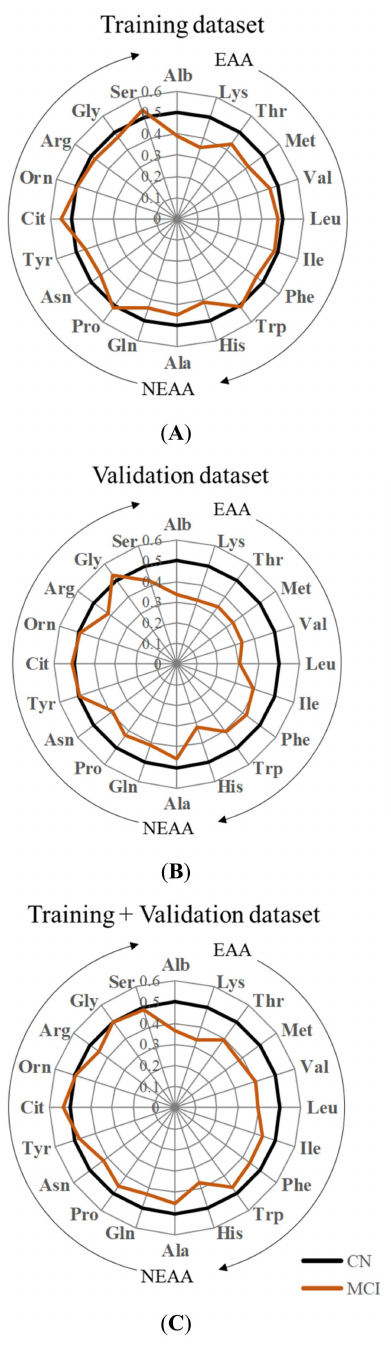
Figure 2. Albumin and PFAA profile of MCI and CN groups. ( A ) Training dataset (120 MCI and 120 CN); ( B ) validation dataset (99 MCI and 100 CN), and ( C ) training + validation dataset (219 MCI and 220 CN). The results of receiver operating characteristic (ROC) curve analysis of albumin and plasma free amino acids (PFAAs) in the training dataset (120 MCI and matching 120 CN) ( A ), the validation dataset (99 MCI and remaining 100 CN) ( B ), and the training and validation dataset (219 MCI and 220 CN) ( C ). Axes show the area under the curve (AUC) of the ROC for albumin and each amino acid for the discrimination of MCI from CN. Black bold lines indicate the point at which the AUC of ROC = 0.5. The MCI labels were fixed as positive class labels. Therefore, an AUC of ROC value < 0.5 indicated the level was lower in the MCI group, whereas a value > 0.5 indicated that the level was higher in the MCI group. EAA; essential amino acids, NEAA; nonessential amino